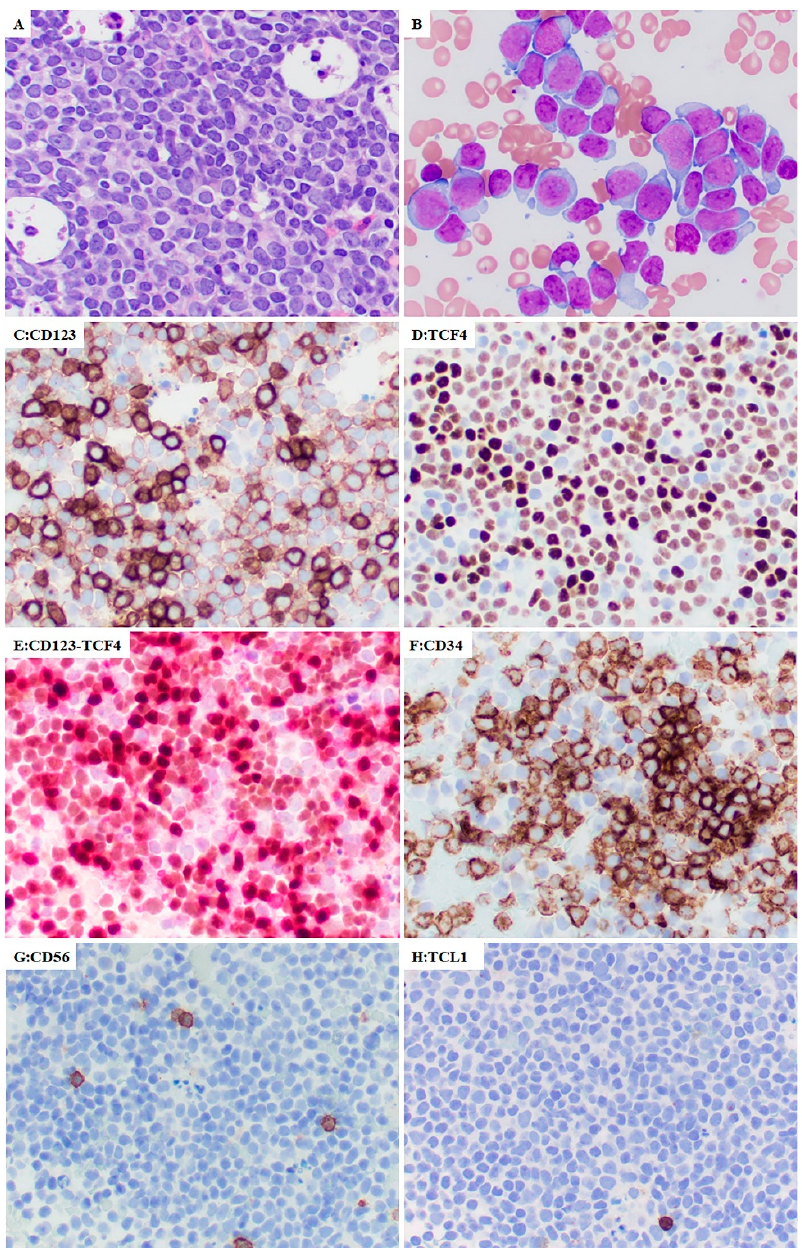
Figure 1. The morphology and immunophenotype (immunohistochemistry) of pDC-AML. ( A ). Diffuse infiltrate of blasts with variable size on bone marrow core biopsy. ( B ). Bone marrow aspirate smear shows two types of cells. One is large with round to slightly irregular nuclei, dispersed chromatin and small to moderate amounts of basophilic cytoplasm, consistent with myeloblasts. Another is smaller and many have dispersed chromatin and cytoplasmic pseudopods, consistent with pDCs. By immunohistochemistry, pDCs are strongly positive for CD123 ( C , E ) and TCF4 ( D , E ), and weakly positive for CD34 ( F ). In contrast, myeloblasts are weakly positive for CD123 ( C , E ) and TCF4 ( D , E ) with strong expression of CD34 ( F ). Both pDCs and myeloblasts are negative for CD56 ( G ) and TCL1 ( H ) in this case.